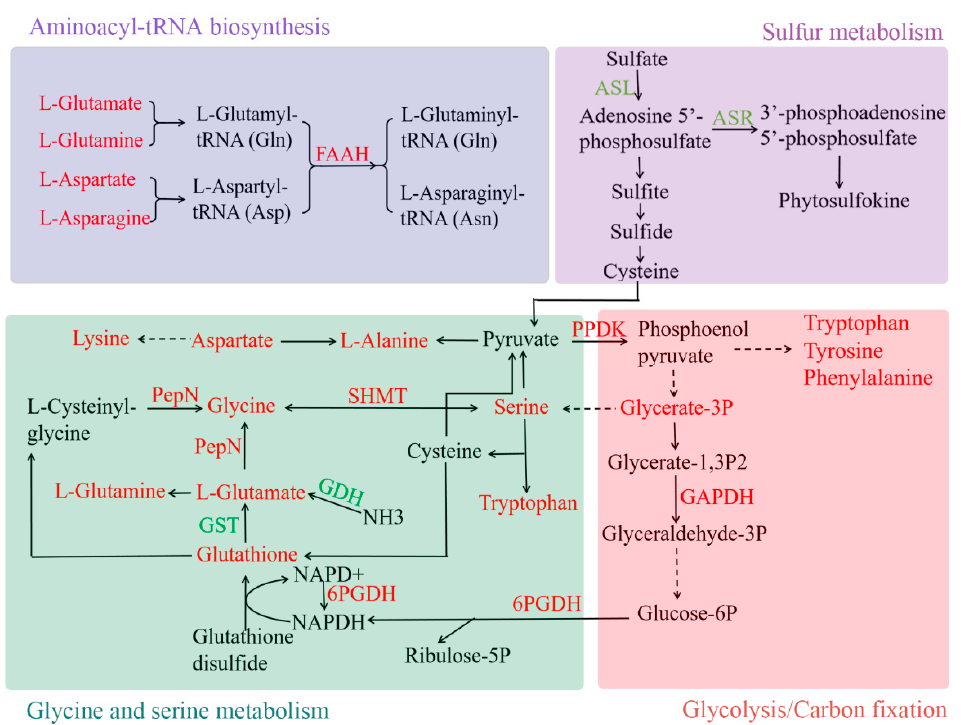
Figure 6. The amino acid metabolism in pea intercropped tea shoots. The red and green colored text indicate up- and down-regulated genes or metabolites, respectively.